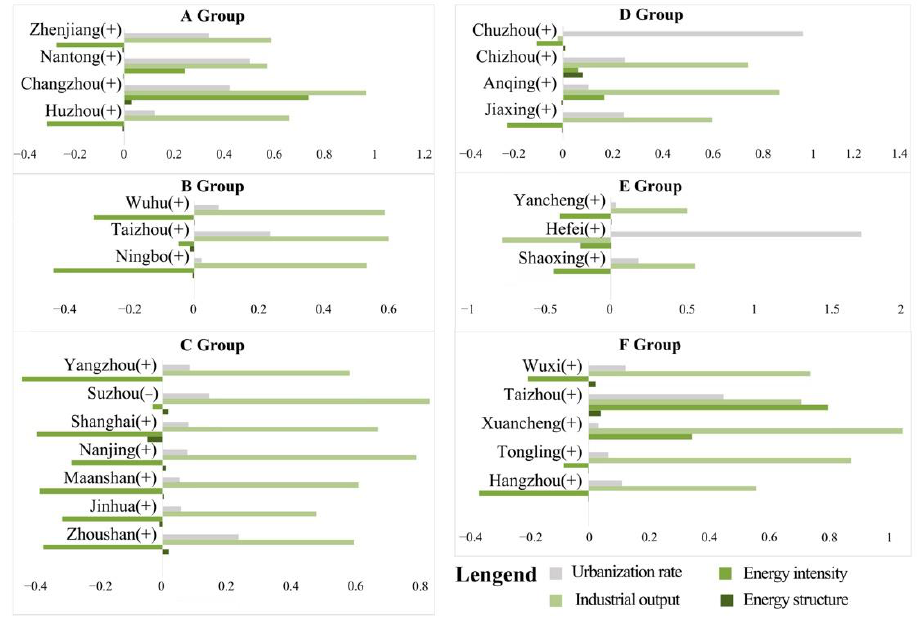
Figure 10. Cluster analysis results in the first period (2000–2005). Note: The symbol (+) after the city indicates an increase in carbon emissions and the symbol (−) indicates a decrease in carbon emissions, the same as in Figures 11 – 13.